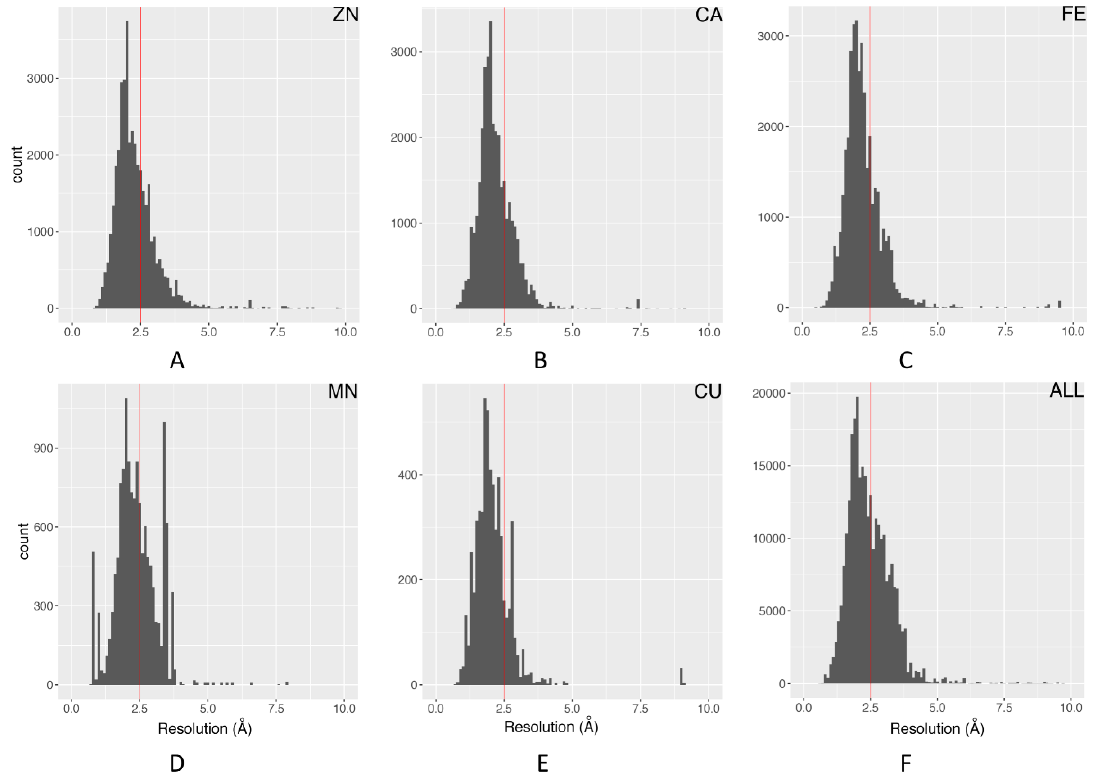
Figure 2. Distribution and 2.5 Å cutoff of structure resolutions: ( A ) Zn; ( B ) Ca; ( C ) Fe; ( D ) Mn; ( E ) Cu; ( F ) all metal ions.